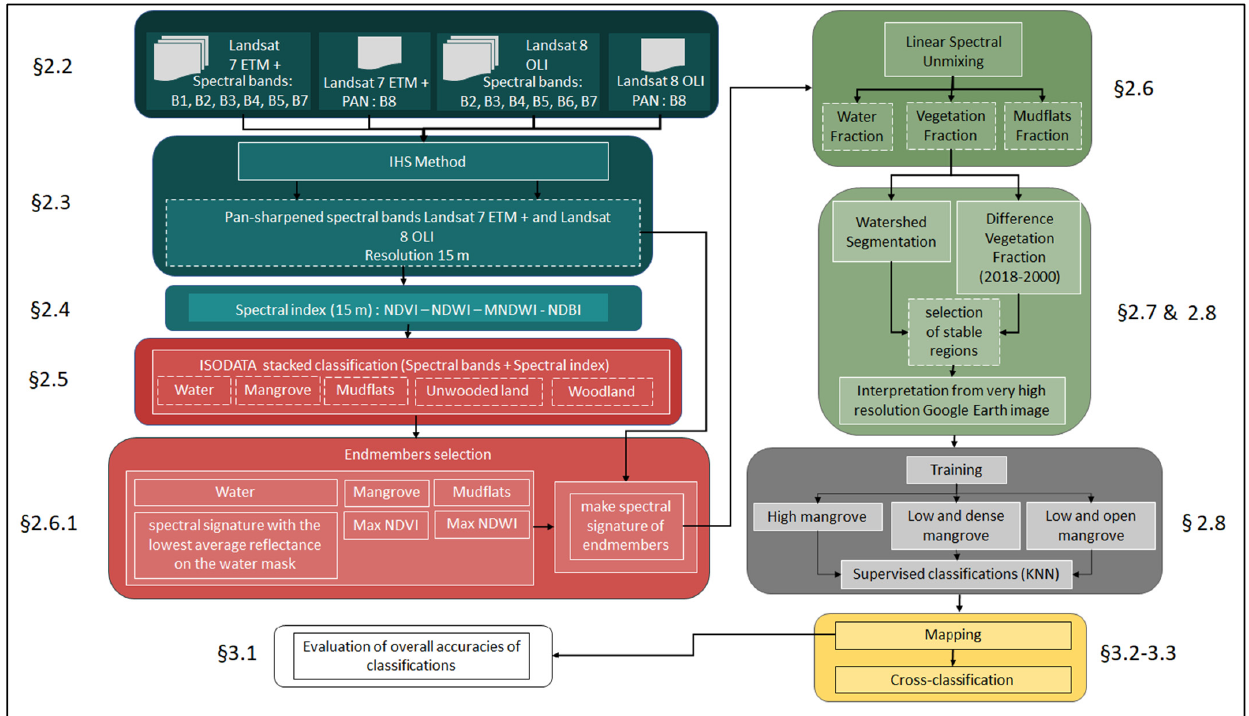
Figure 5. Methodological flowchart for mapping the mangrove zonation